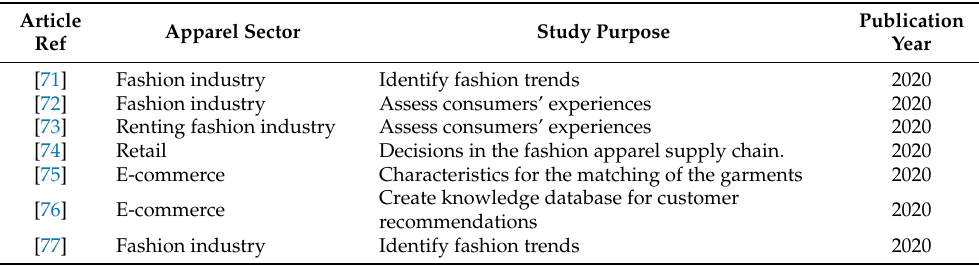
Table 3. Shortlisted research papers as a result of a screening process related to Text Mining and Apparel Industry as shown in Figure